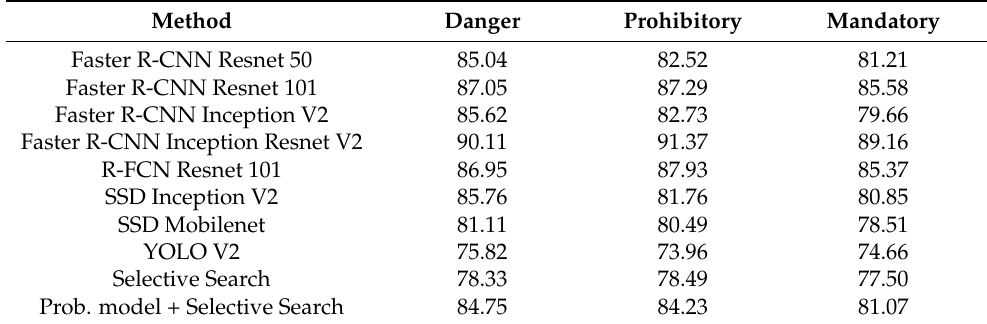
Table 6. Average IoU values in percentage.